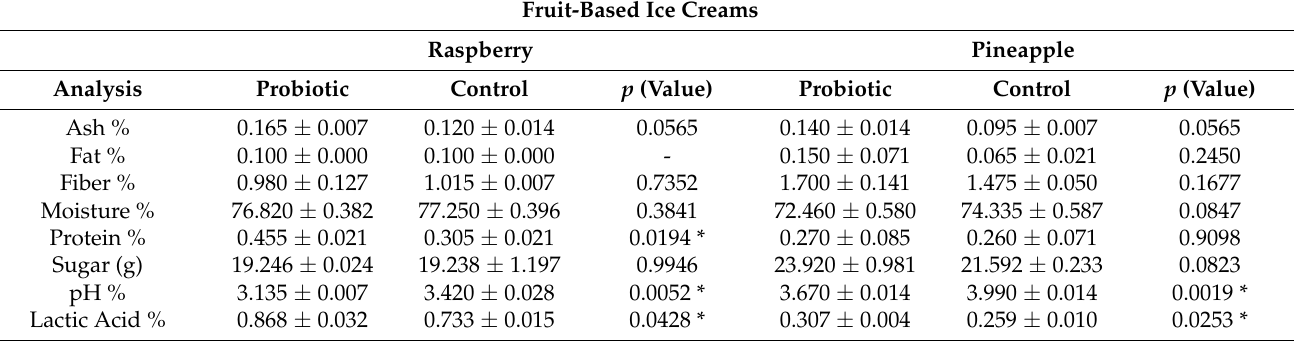
Table 3. Chemical compositions in the control and probiotic L. fermentum UCO-979C fruit-based ice creams.